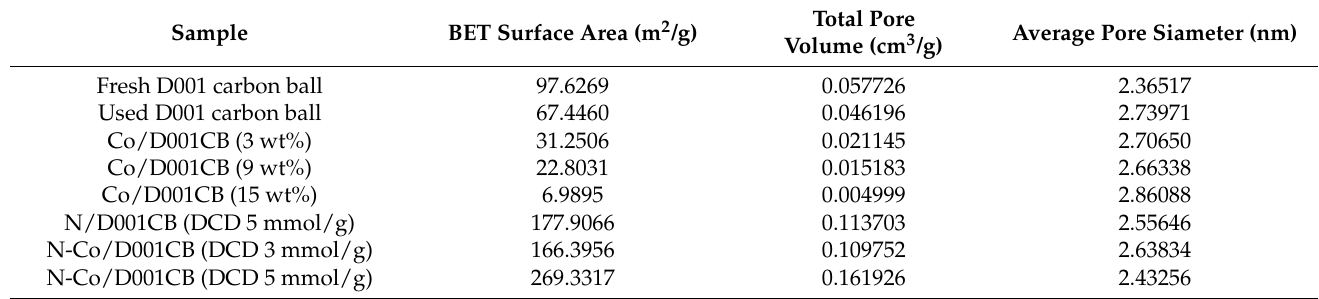
Table 1. Specific surface area, total pore volume, and pore size of several